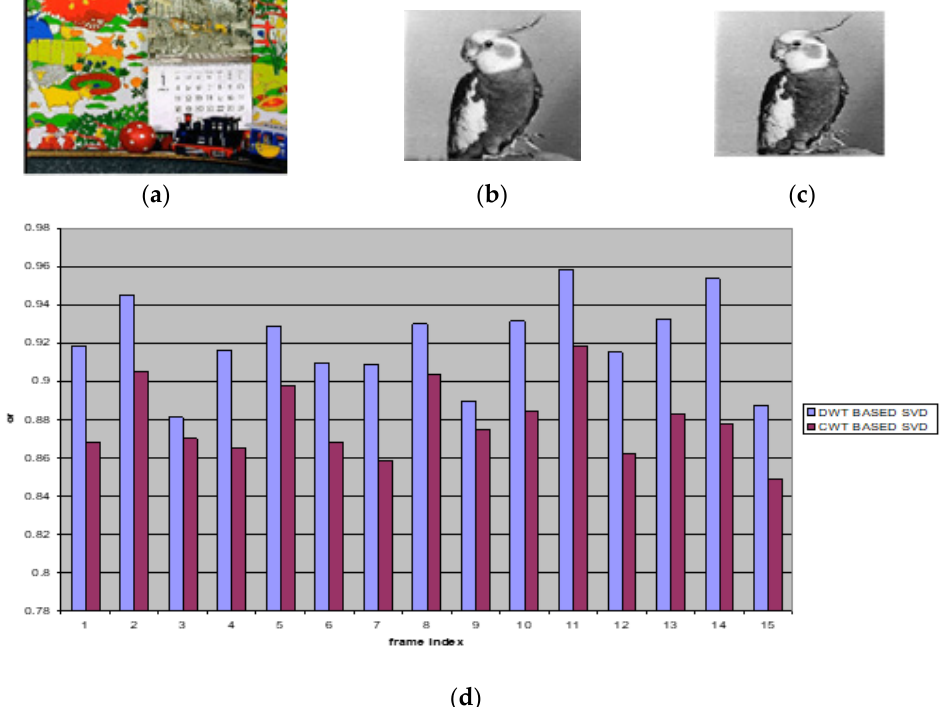
Figure 15. ( a ) The watermarked frame under the histeq attack using the proposed method. ( b ) Extracted watermark from frame 10 of the first video scene in the proposed method. ( c ) Extracted watermark from frame 10 of the first video scene for the DWT-based SVD method. ( d ) Correlation values for the extracted watermarks for frames 1 to 15 in the first video scene under histeq attacks.